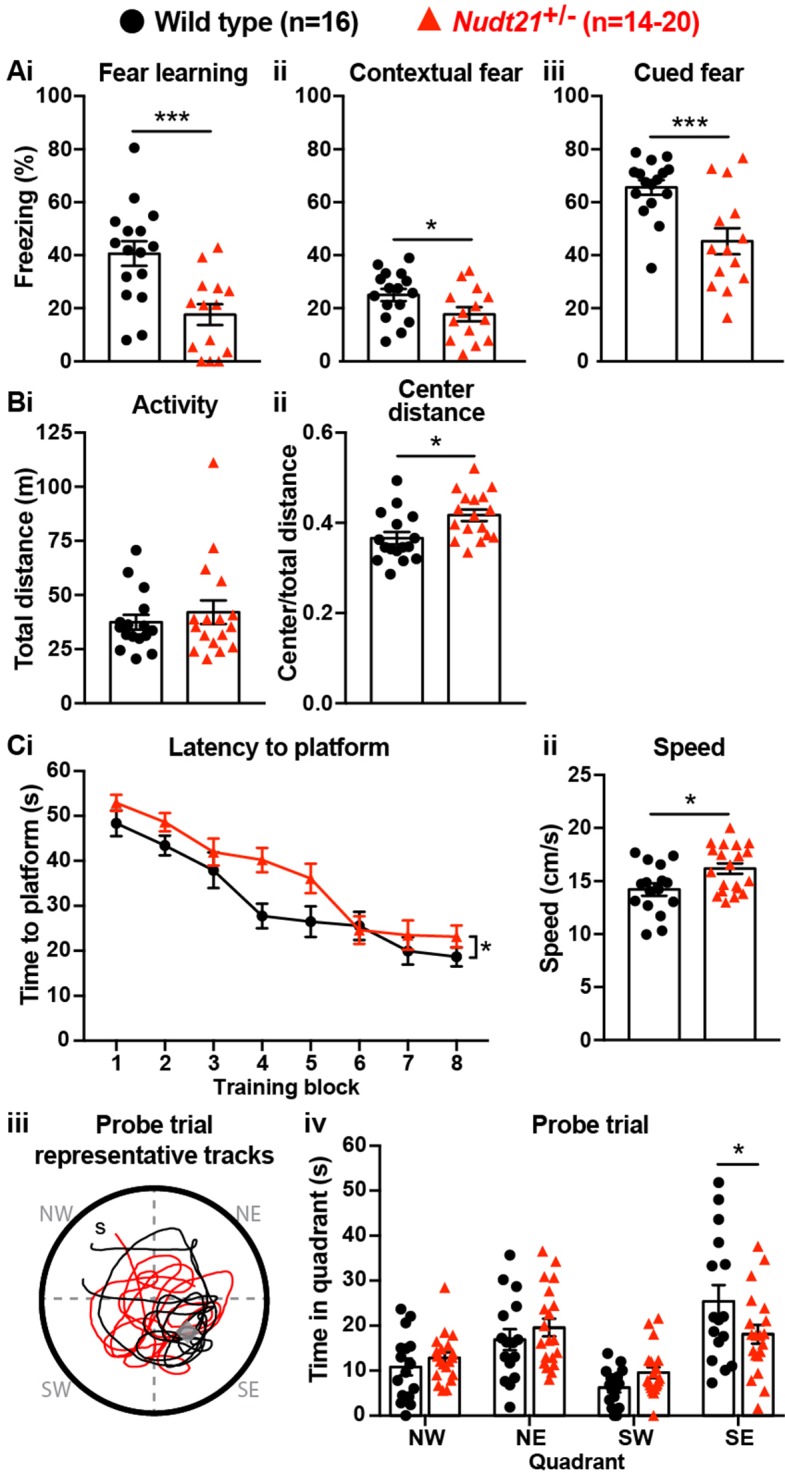
Partial loss of Nudt21-encoded CFIm25 protein causes learning deficits.(A) Nudt21+/- mice have conditioned fear learning deficits: fear learning, p=0.0009; contextual fear, p=0.045; cued fear, p=0.0009. (B) The open field assay shows that Nudt21+/- mice are no more active (i) but spend relatively more time in the center of the open field (ii), indicating reduced anxiety: p=0.01. (C) Nudt21+/- mice have spatial learning deficits in the Morris water maze. (i) They take longer to find the hidden platform during the training blocks (p=0.026, two-way, repeated measures ANOVA), (ii) despite swimming faster and farther (p=0.013). (iii and iv) When the hidden platform is removed in the probe trial, they spend less time in the quadrant that previously had the platform (p=0.039, Sidak’s multiple comparisons test). For all assays, mice were between 30–40 weeks of age. Error bars indicate SEM. Representative tracks are from the animal with the median result in each genotype. All data were analyzed by unpaired, two-tailed t-test unless otherwise stated. *p<0.05; ***p<0.001.